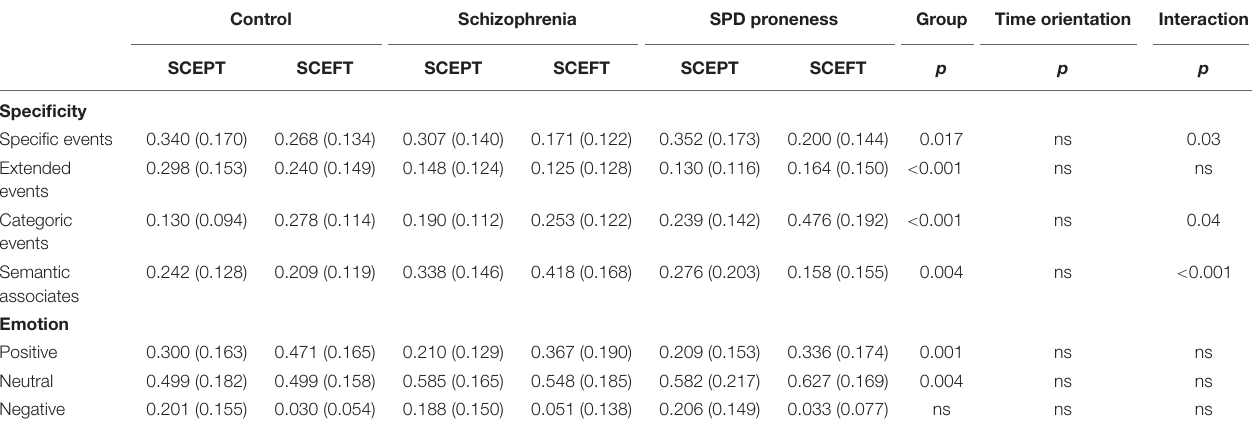
TABLE 2 | Mean (SD) proportions of the different response categories across task type in participants.